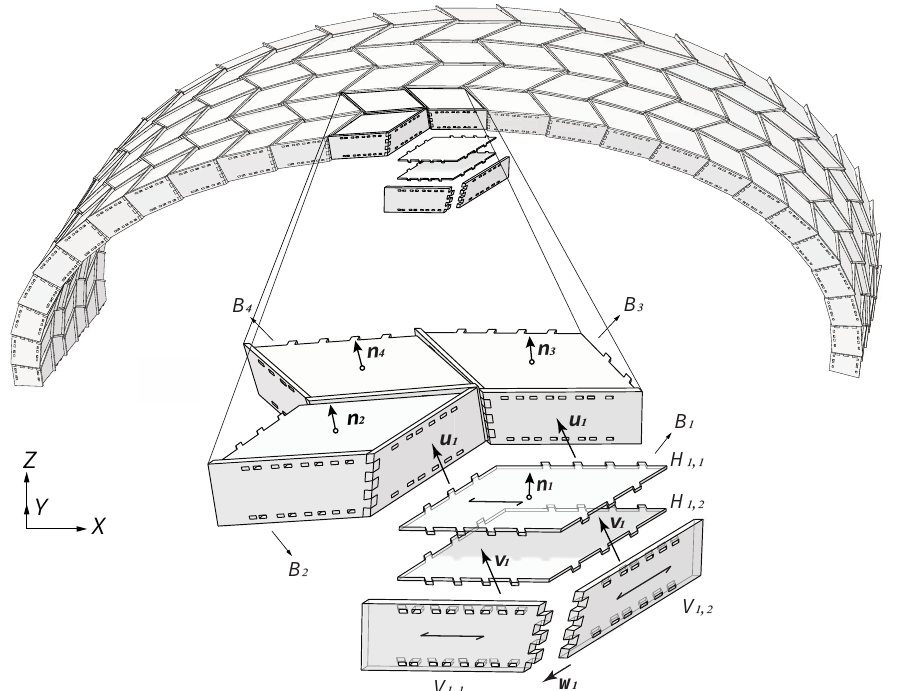
Figure A1. Assembly system of double-layered double-curved timber plate shells developed by Robeller et al.